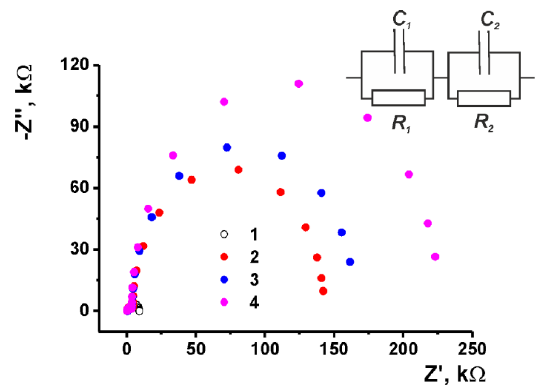
Figure 4. The Nyquist diagram obtained with the glassy carbon electrode (1) covered with poly(Azure B–proflavine) prior to (2) and after (3) application of DNA (2 μL of 1.0 mg/mL solution in 0.1 M HEPES + 0.03 M NaCl, pH = 7.0) or DNA-1.0 nM doxorubicin aliquot (4). Measurements in 0.025 M PB + 0.1 M KCl, pH = 7.0, in the presence of 10 mM [Fe(CN) 6 ] 3−/4− . Inset: equivalent circuit, C —constant phase element, R —charge transfer resistance.